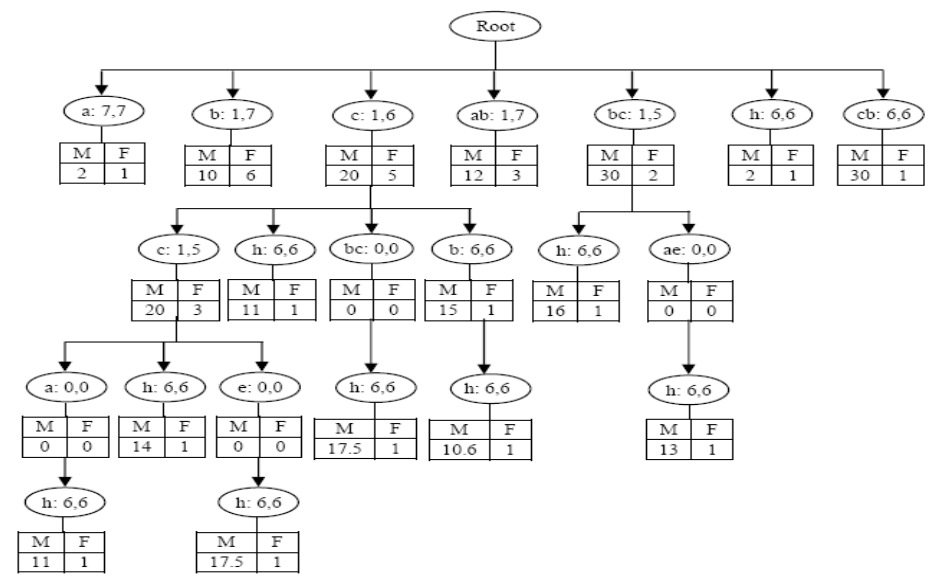
Fig. 3. Updated CFM -tree with no Incompact Nodes